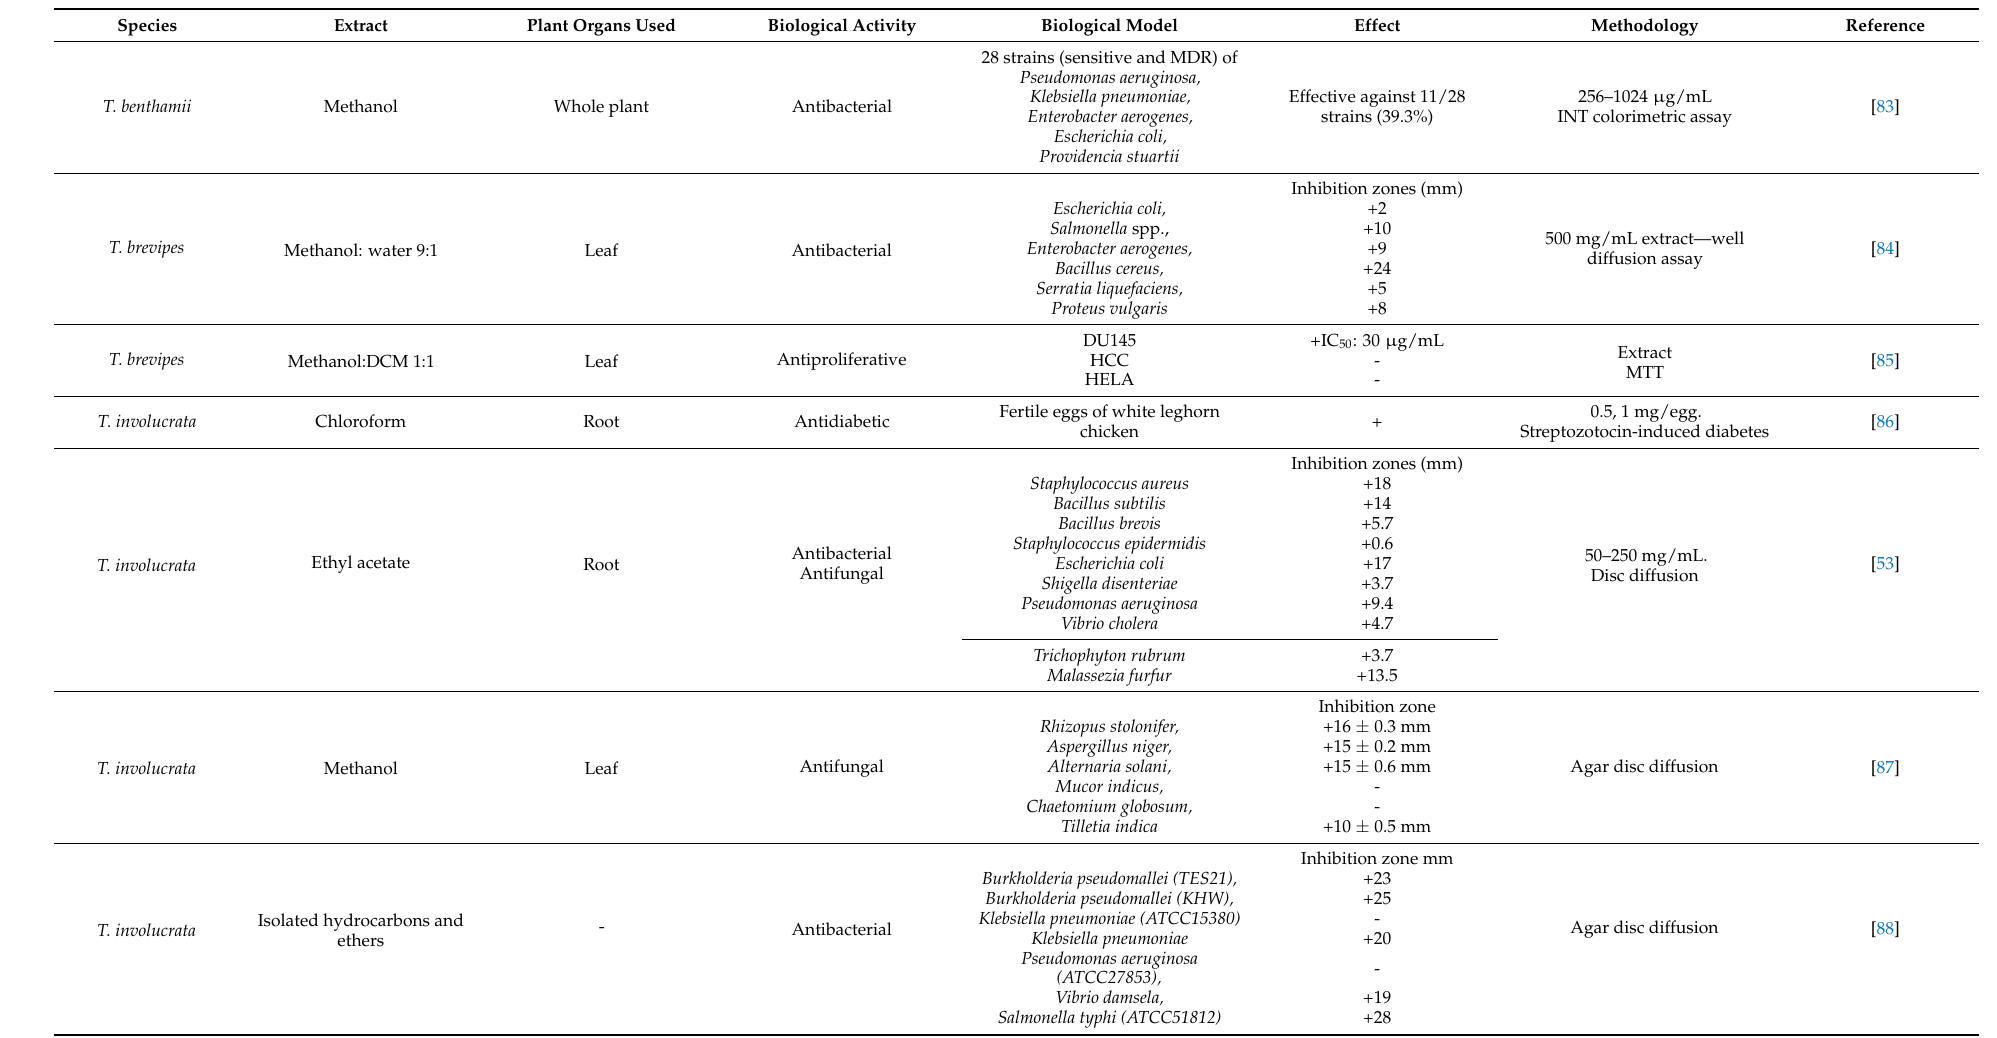
Table 2. In vitro activity of Tragia extracts. Species are in alphabetical